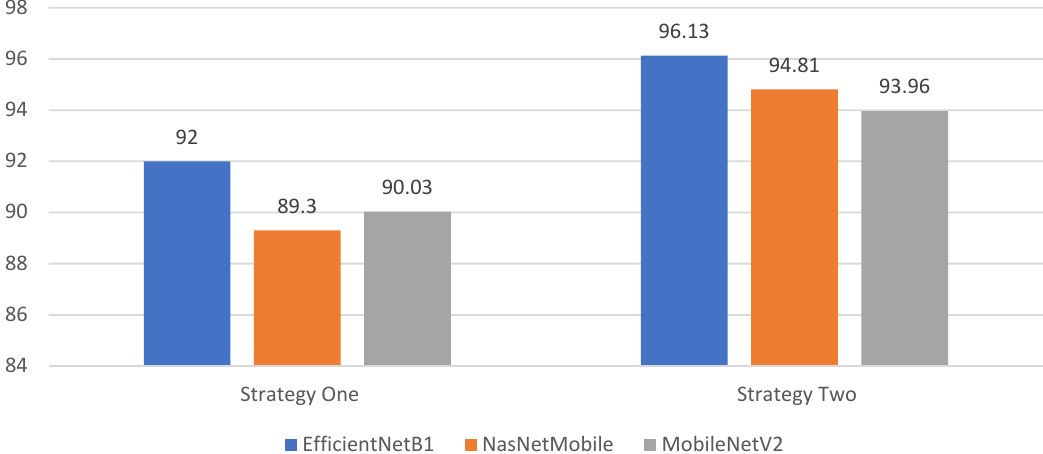
Figure 8. Performance comparison between Strategy I and Strategy II.